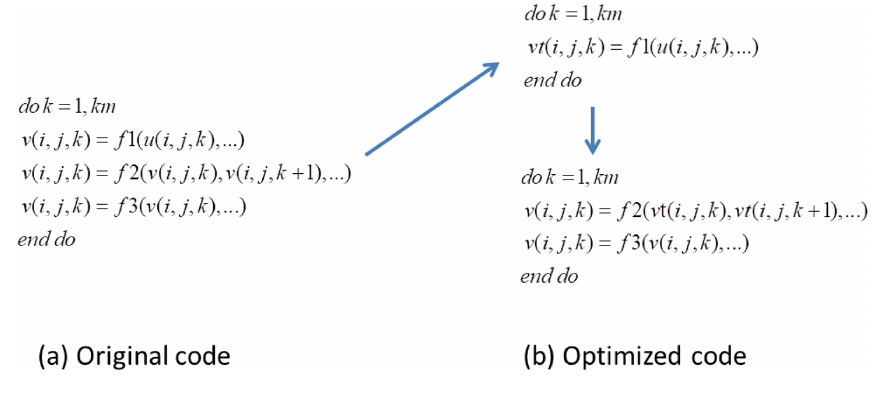
Figure 4. The code using temporary arrays to avoid data dependency.